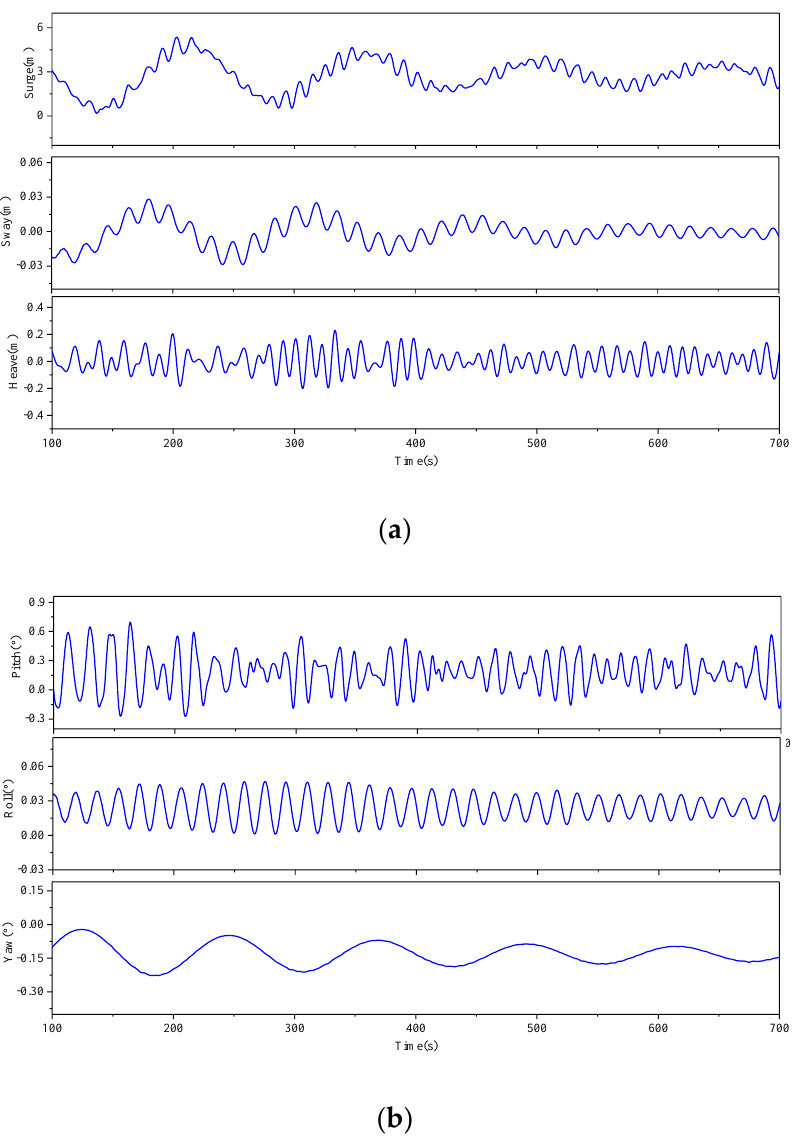
Figure 12. Time histories of cage motions under the uniform wind with irregular waves. ( a ) Transla- tional motion. ( b ) Rotational motion.